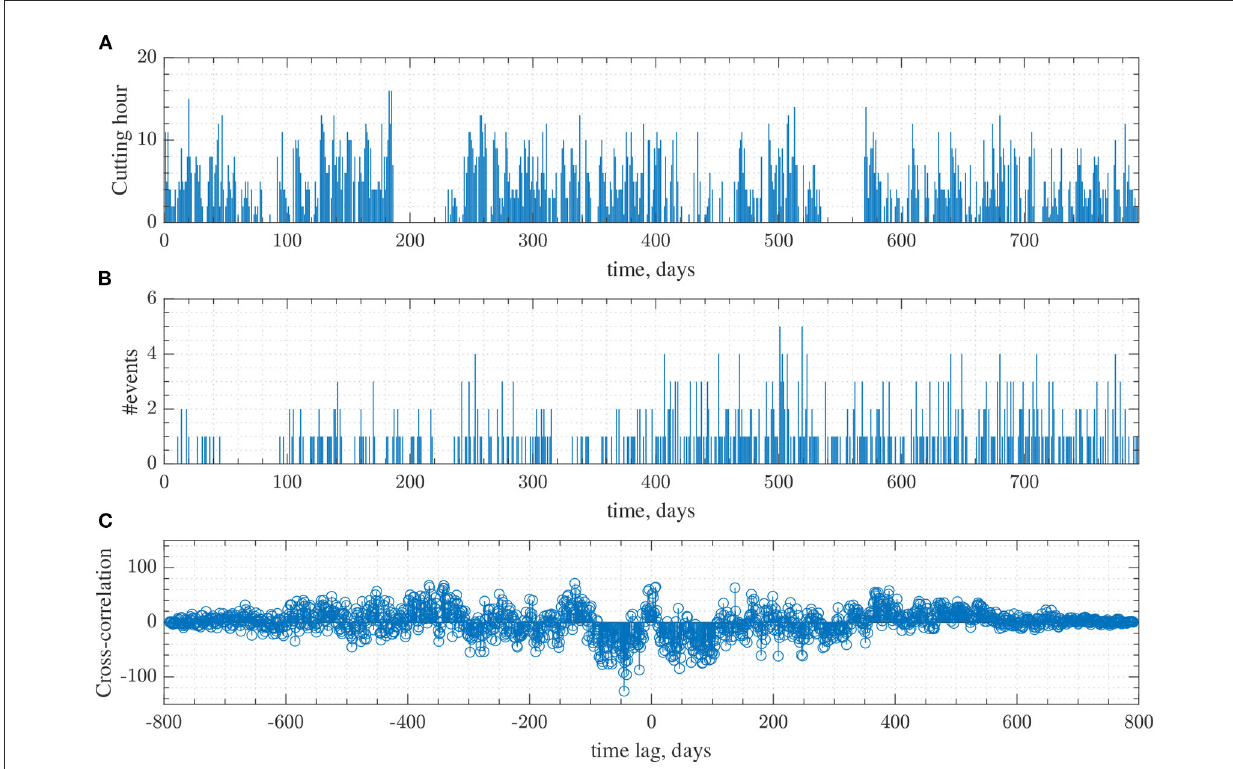
FIGURE7 Cross-correlation analysis between microseismicity rate and the mine cutting operation rate in Subregion 2 of the mine. (A) The mine-cutting operations are given as the number of cutting hours per day. (B) The seismicity rate is computed as the number of events above magnitude m 0.94 per day. (C) The cross-correlation coefficient vs. time lag is given. = −